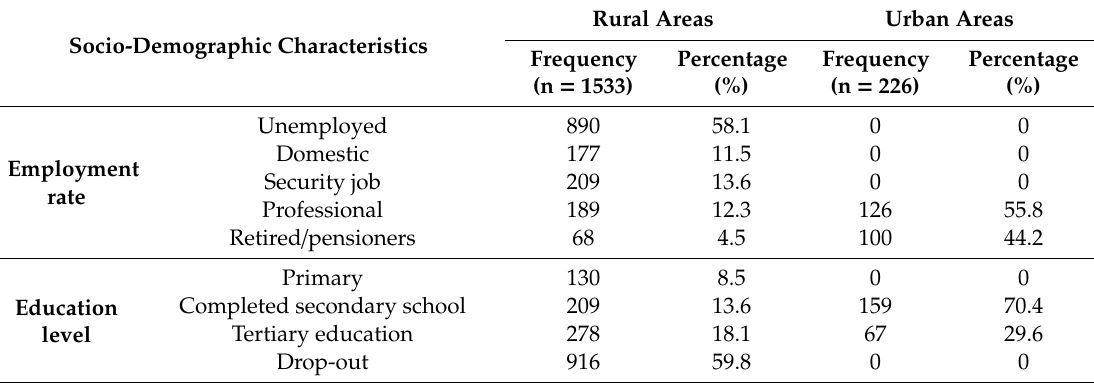
Table 3. An overview of the disparities in employment and education level in the Ugu District Municipality.